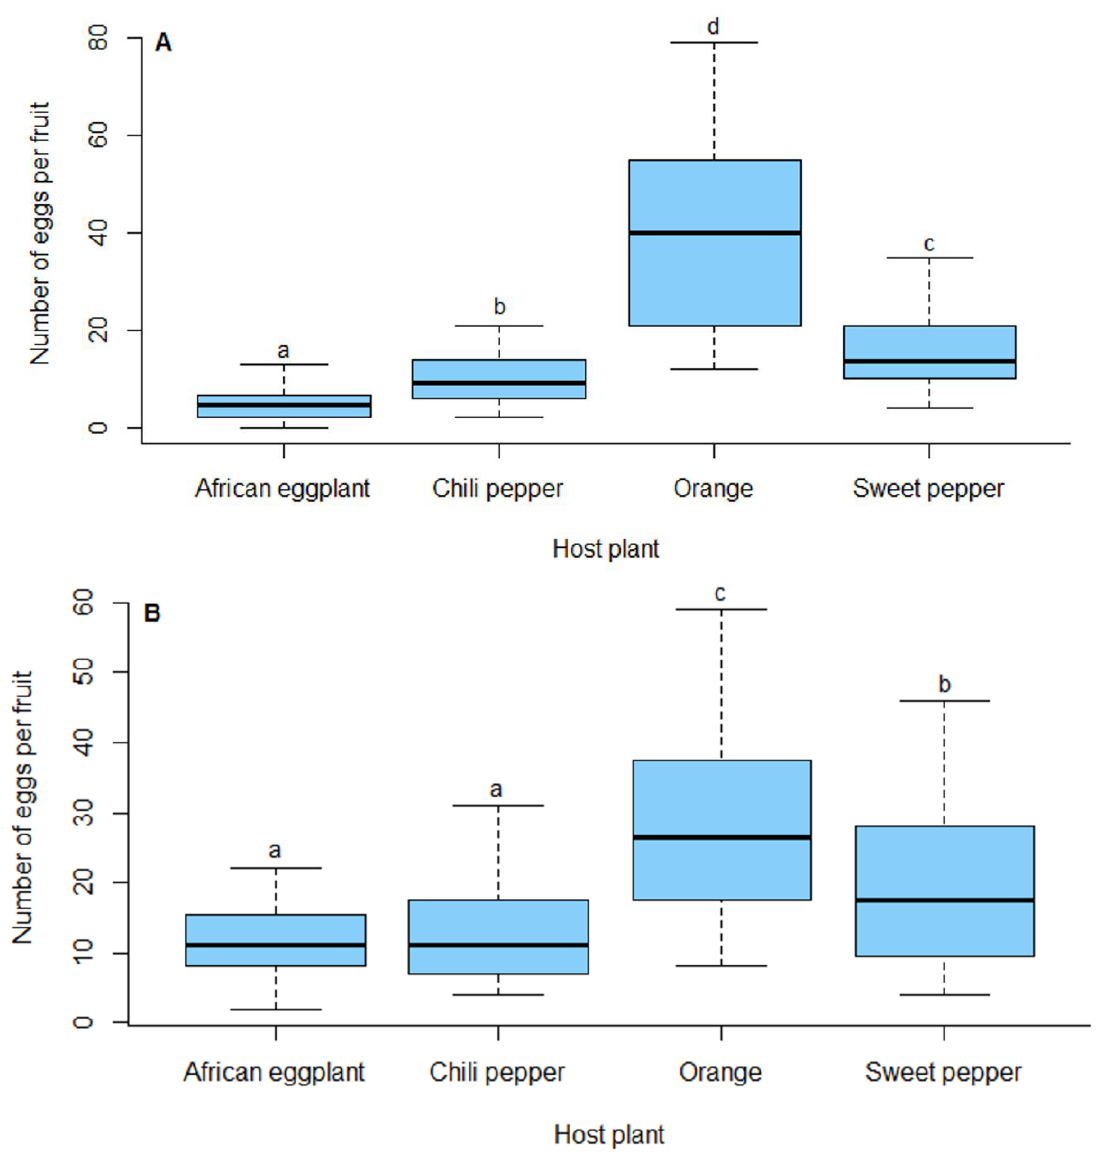
Figure 2. Number of eggs laid by Thaumatotibia leucotreta on different host plants in choice ( A ) and no-choice ( B ) experiments. Boxes caped with the same letter are not significantly different ( p = 0.05, Tukey’s HSD).